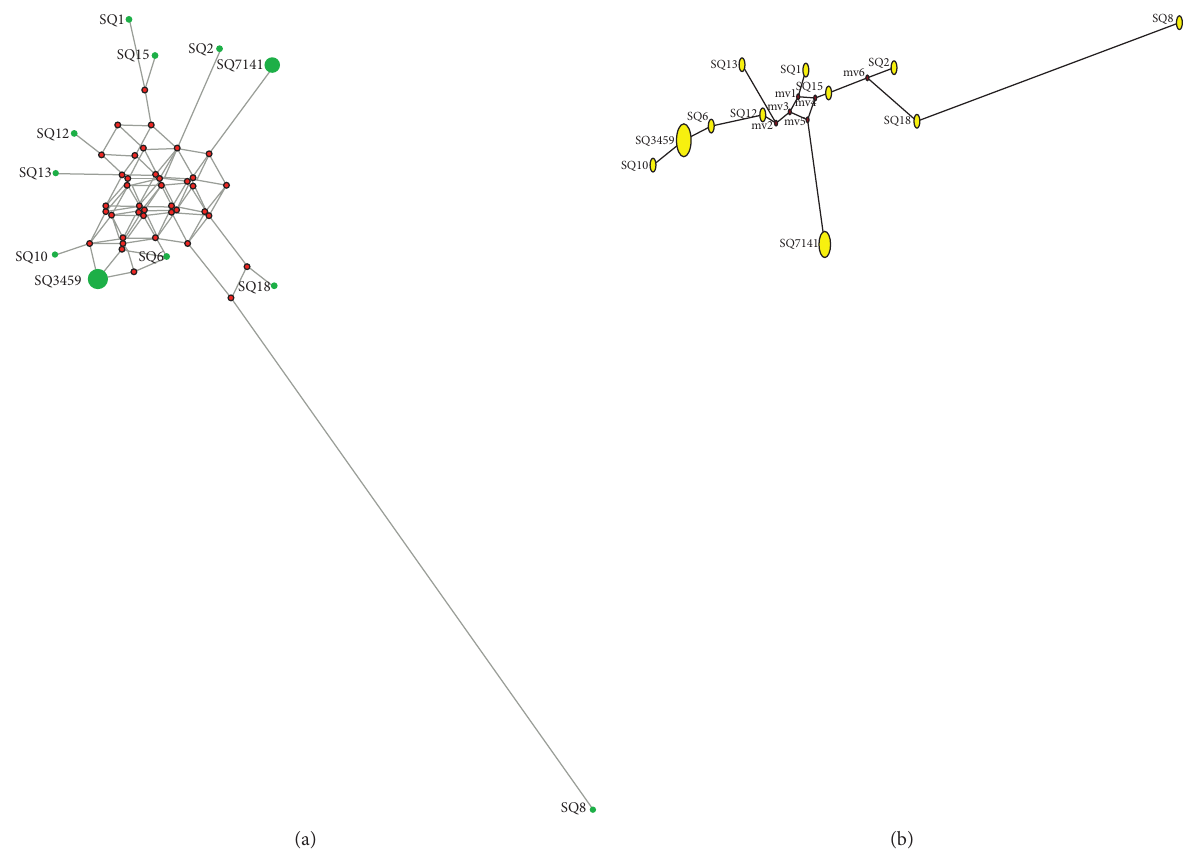
Figure 4: YSTR haplotype network (a) and phylogenetic tree (b) of AME-Y-null Pakistani males drawn using the median joining